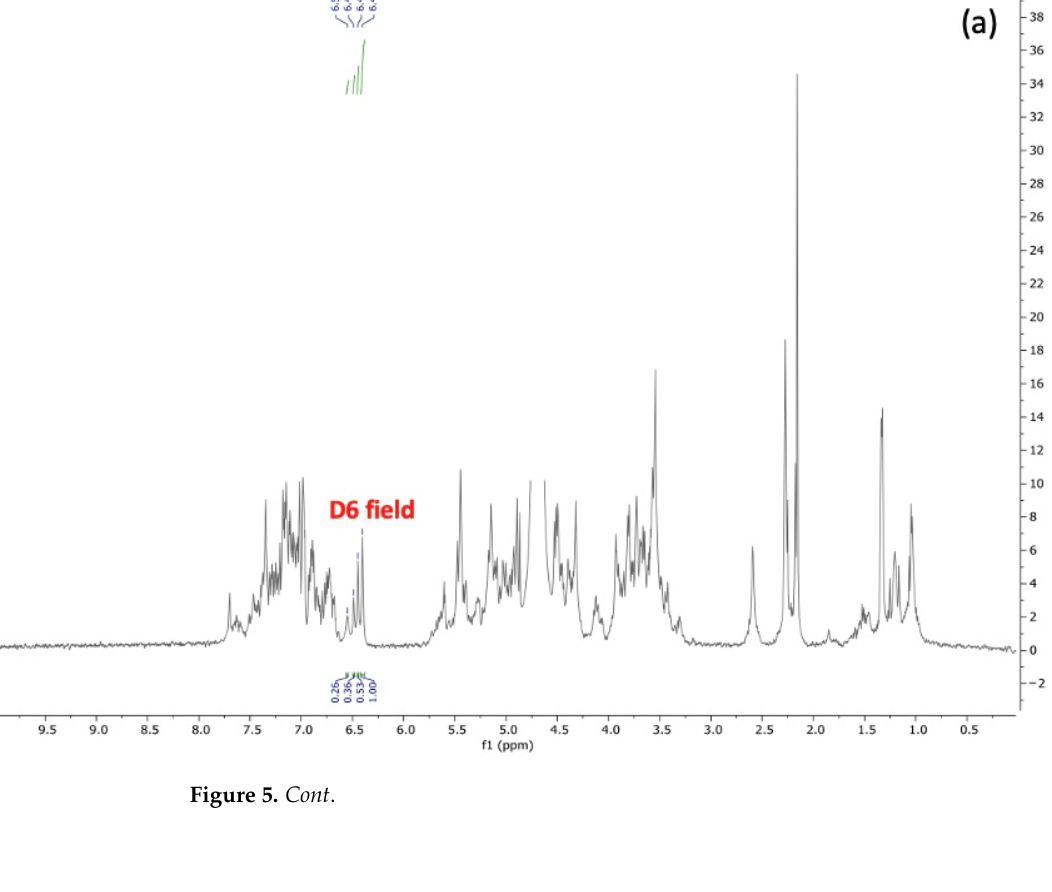
Figure 4. Chemical structure of avoparcin possible sites of attachment of the second ristosamine residue giving rise to the respective ristosamynil-avoparcin are shown by arrows. Functionalization occurs at the level of the D aryl ring.